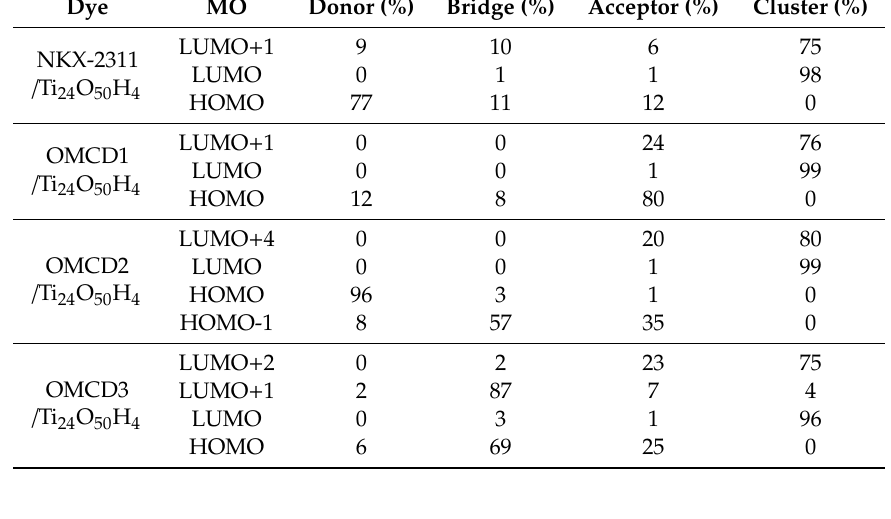
Table 5. Contributions of the donor, π -bridge, acceptor units and the Ti 24 O 50 H 4 nanocluster to the electron density of the main molecular orbitals of the adsorbed dyes, calculated at the DFT / B3LYP / DZVP level.